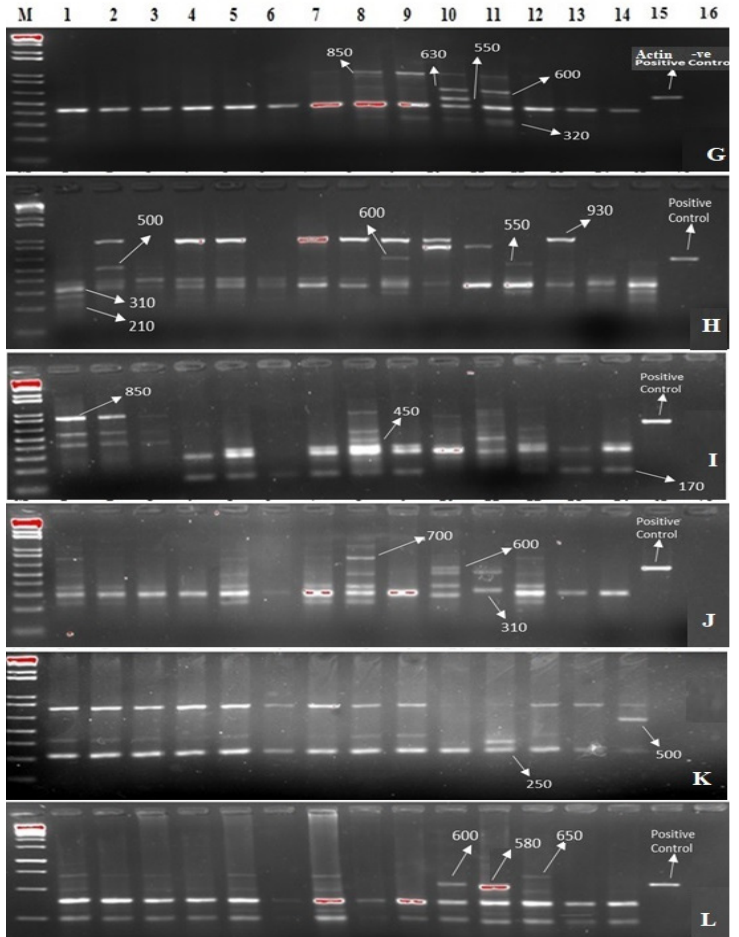
Figure 5. ( G ) ISSR-3 marker UBC-815 uniquely identified Grand-Naine, Dhaka, and Fenjiao with band sizes 320, 600, 550, 630, and 850 bp. ( H ) ISSR marker UBC-827 uniquely identified NIGAB-1, NIGAB-2, Red banana, Fenjiao, and Basrai with band sizes 210, 310, 500, 600, 550, and 930 bp. ( I ) ISSR marker UBC-808 uniquely identified NIGAB-1, Grand-Naine, Dhaka, and Sprout-2 with band sizes 170, 450, and 850 bp. ( J ) ISSR marker UBC-822 uniquely identified Grand-Naine, Dhaka, Dajiao, and Fenjiao with band sizes 310, 600, and 700 bp, ( K ) ISSR marker UBC-817 uniquely identified Dajiao and Fenjiao with band sizes 250 and 500 bp. ( L ) ISSR marker UBC-826 uniquely identified Dajiao, Fenjiao, and Basrai with band sizes 580, 600, and 650